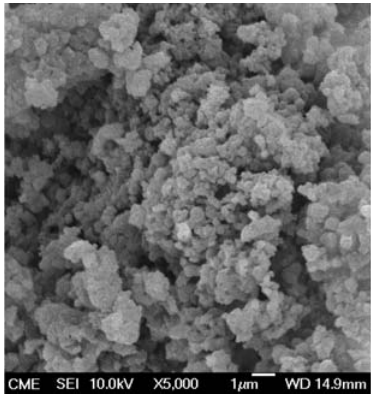
Figure 1. SEM micrograph of 5-FU-loaded folate-conjugate nanogel (F-SubMGs) after